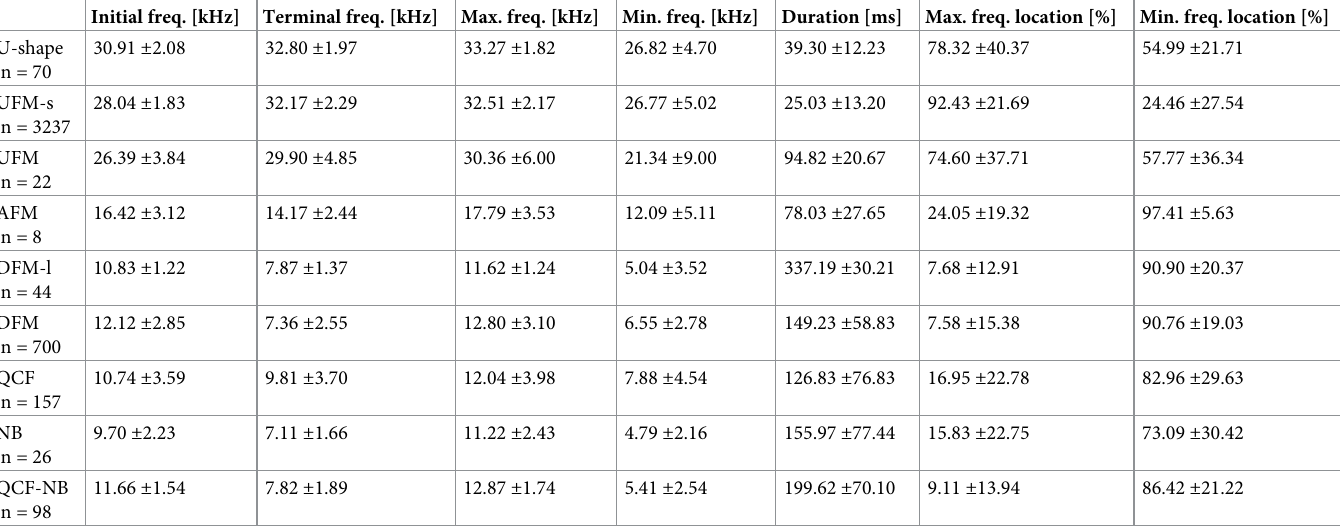
Spectro-temporal features of nine call types are shown. Frequency of fundamental frequency (F0) at which the call began (Initial freq.), frequency of F0 at which the call ended (Terminal freq.), maximum frequency attained by F0 (Max. freq.), minimum frequency attained by F0 (Min. freq.), total duration (Duration), maximum frequency location (percentage of total duration; Max. freq. location), and minimum frequency location (percentage of total duration; Min. freq. location) are shown. Mean ± S.D. are